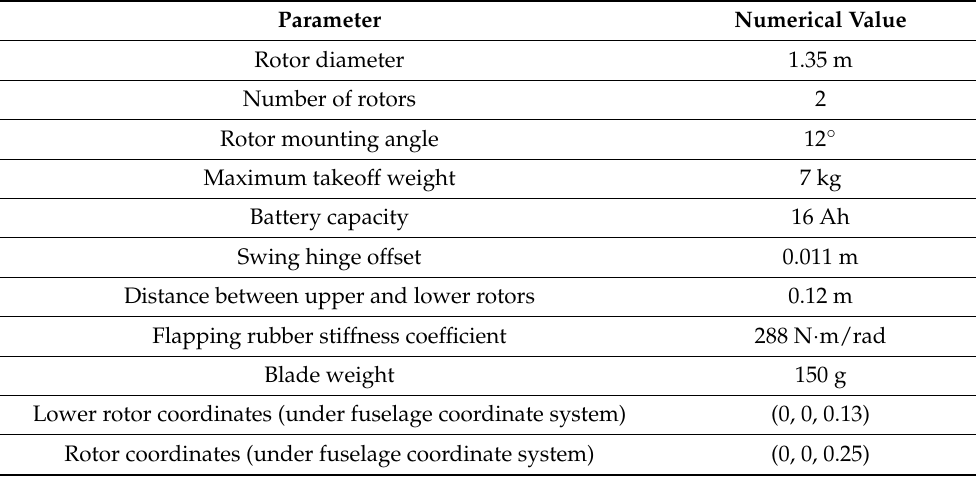
Table 1. D-07 parameters.